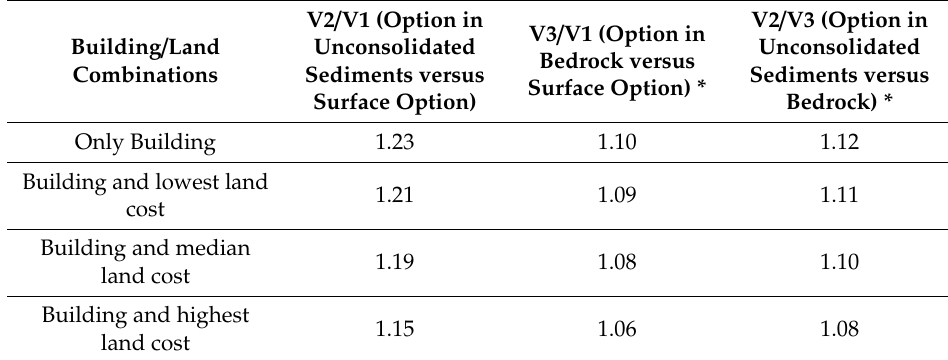
Table 6. Comparison when adding the cost of land purchase (adapted from Maire 2011, p.